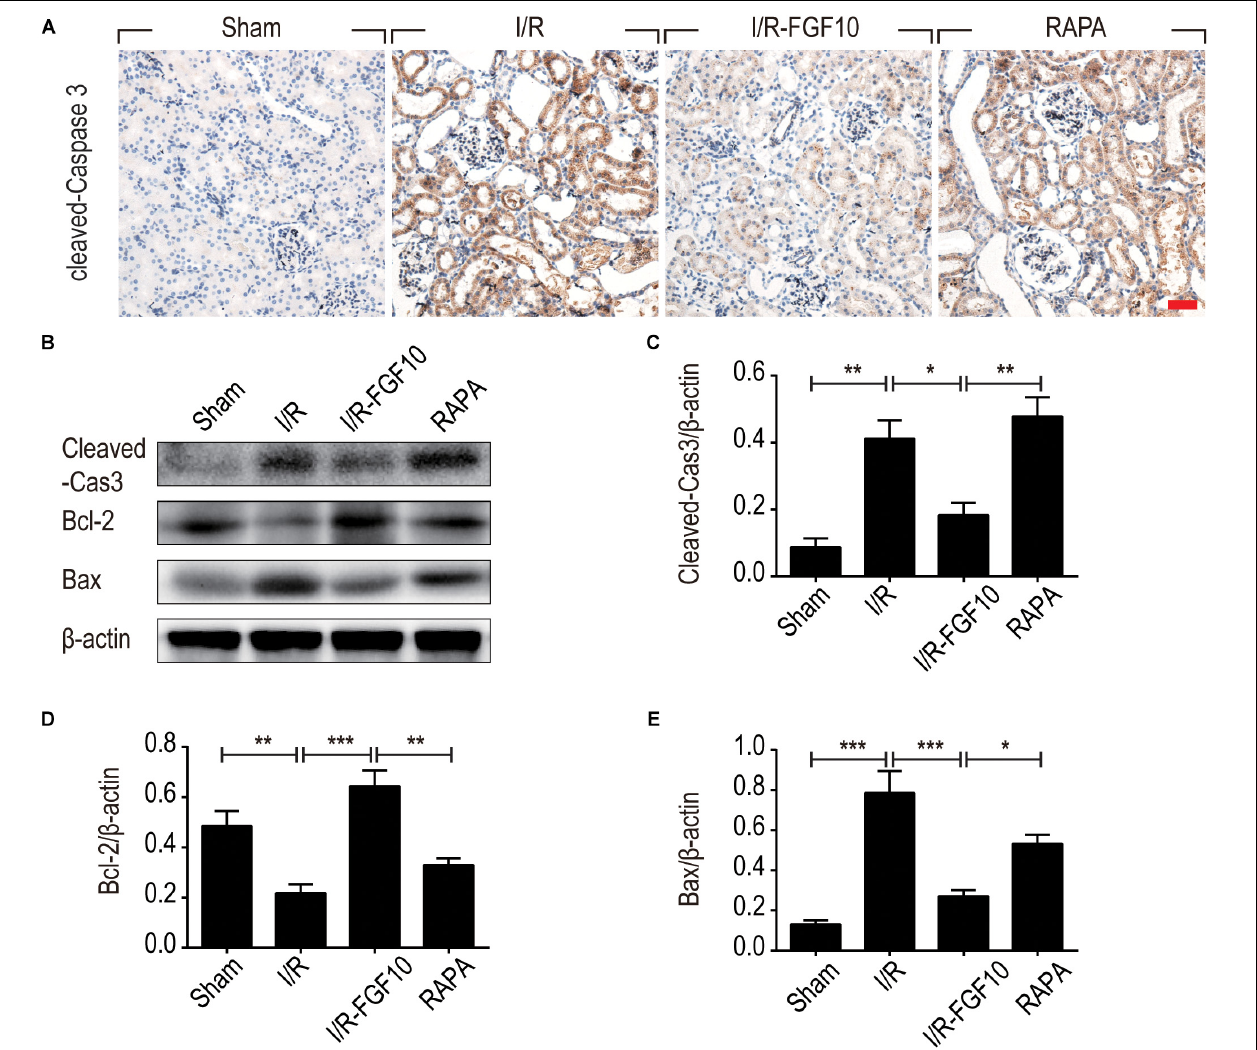
FIGURE 3 | FGF10 reduces the expression of pro-apoptotic proteins IHC staining and Western blot analyses were performed at 2 days after reperfusion. (A) IHC staining for cleaved caspase-3 in kidneys of indicated groups. Scale bars = 50 µ m. (B) The expression of cleaved Caspase-3, Bcl-2 and Bax were detected by Western blot with β -actin as loading control. (C–E) The optical density analysis of cleaved Caspase-3, Bcl-2 and Bax (mean ± SEM; n = 5). ∗ P < 0.05, ∗∗ P < 0.01, ∗∗∗ P < 0.001.